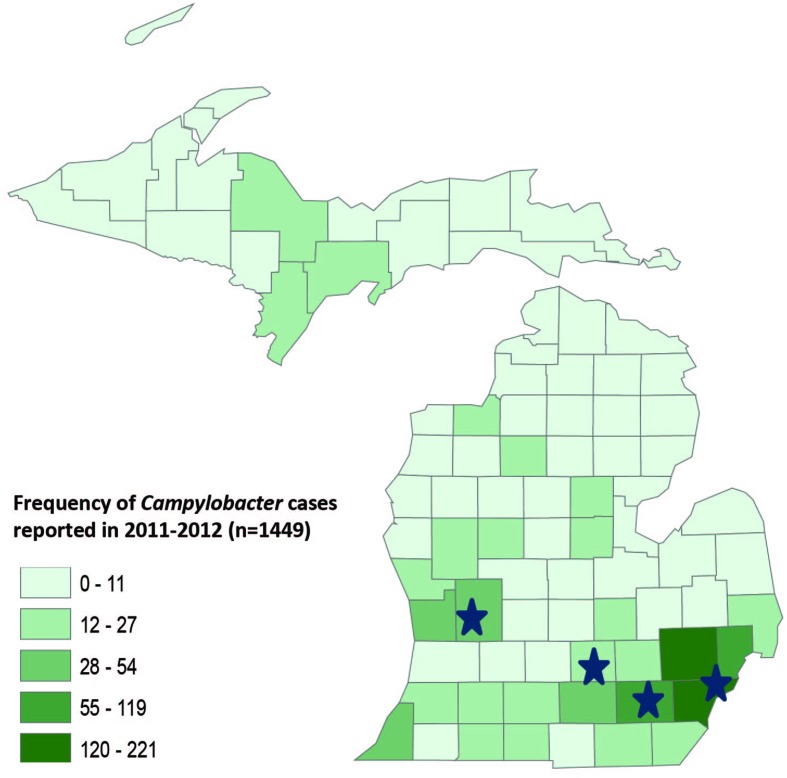
GIS map of Michigan by county showing the frequency of Campylobacter cases reported in 2011–2012. The stars represent the location of four hospitals where the samples were collected.